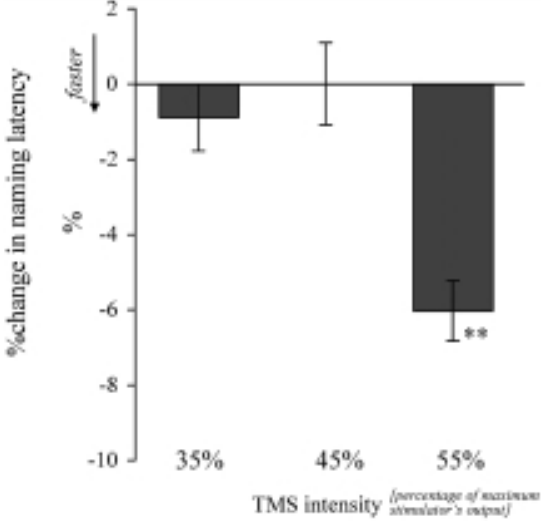
Fig. 6. The observed rTMS effect on naming is intensity depen- dent